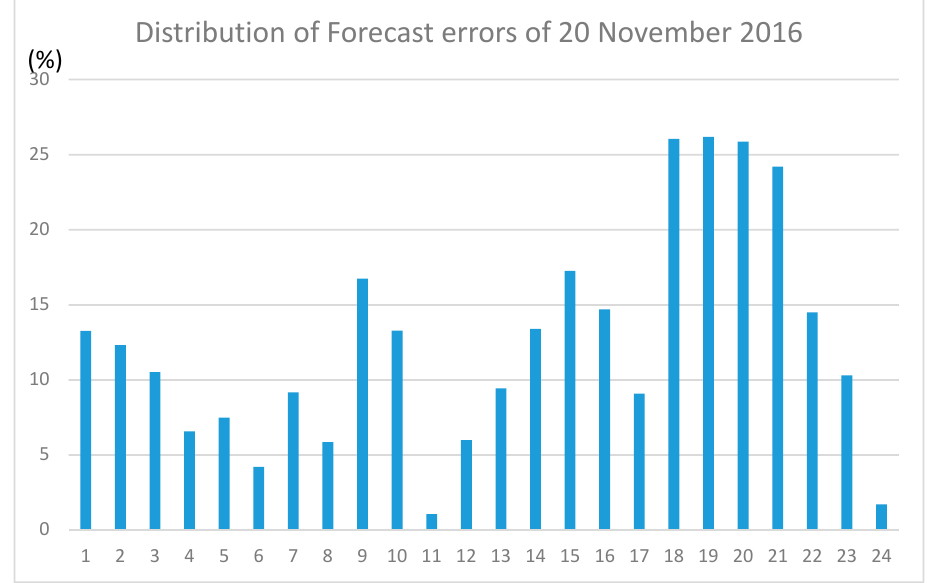
Figure 17. Distribution of forecast errors of 20 November 2016 forecasting.